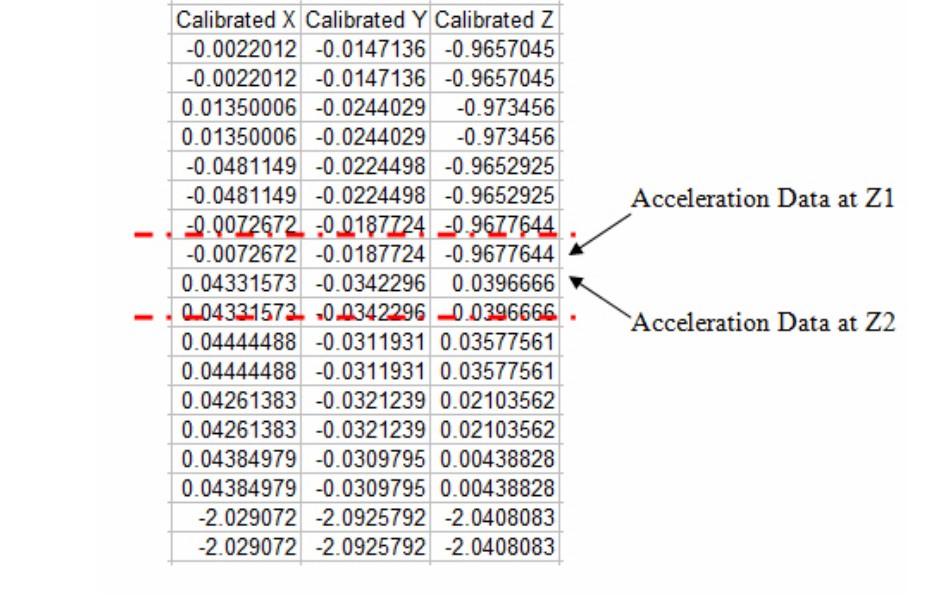
Figure 4. The acceleration data within the dotted line represents the duration of time prior to and after the fall captured by the triaxial accelerometer